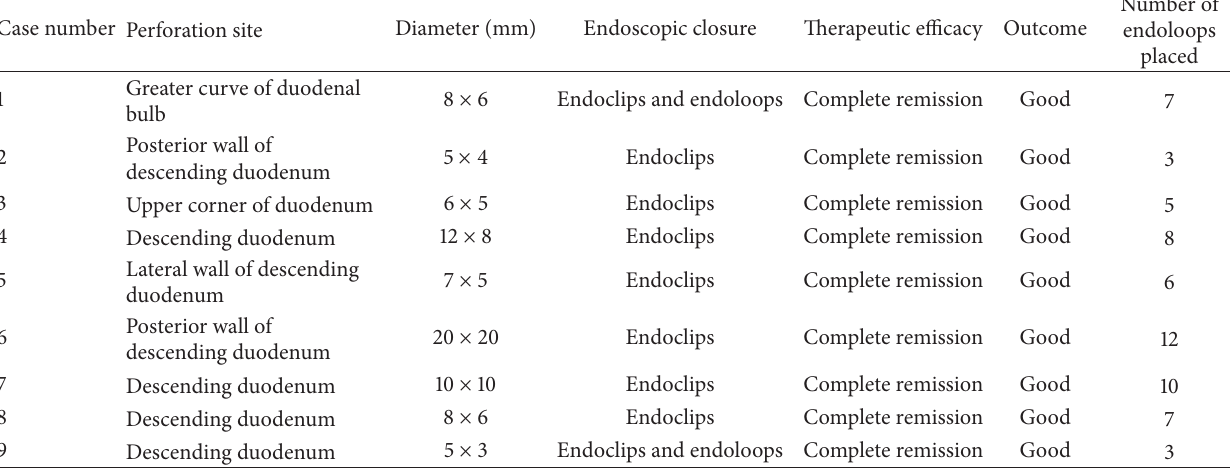
Table 2: Endoscopic closure of the duodenal